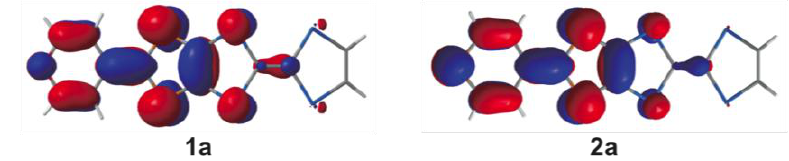
Figure 2. The HOMO of 1a (left) and 2a (right). The energy levels are −4.50 eV for 1a and −4.52 eV for 2a